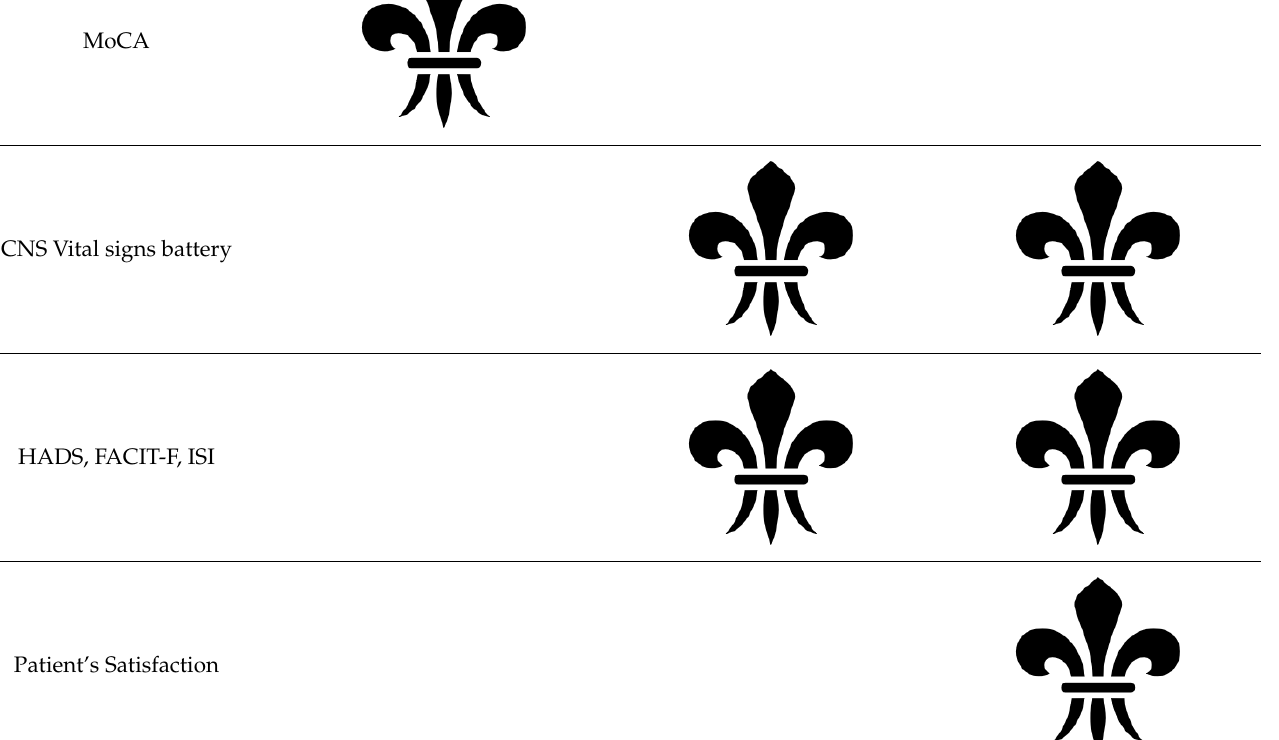
Table 1. Details concerning data